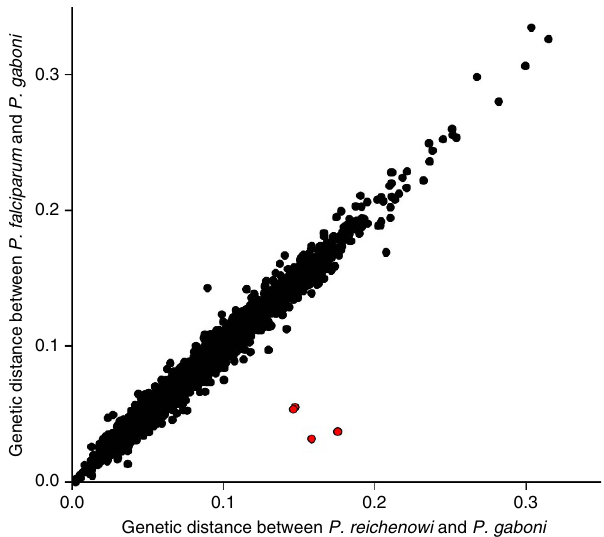
Figure 4 | Genome-wide comparison of Laverania inter-species distances. Pairwise inter-species distances (substitutions per site) were calculated for all genes (dots) for which orthologs were identified in all three Laverania species ( n ¼ 4,500), and the P. reichenowi – P. gaboni ( x -axis) and P. falciparum – P. gaboni ( y -axis) distances were plotted. Four genes that exhibit an unusually high P. reichenowi – P. gaboni and an unusually low P. falciparum – P. gaboni distance are highlighted in